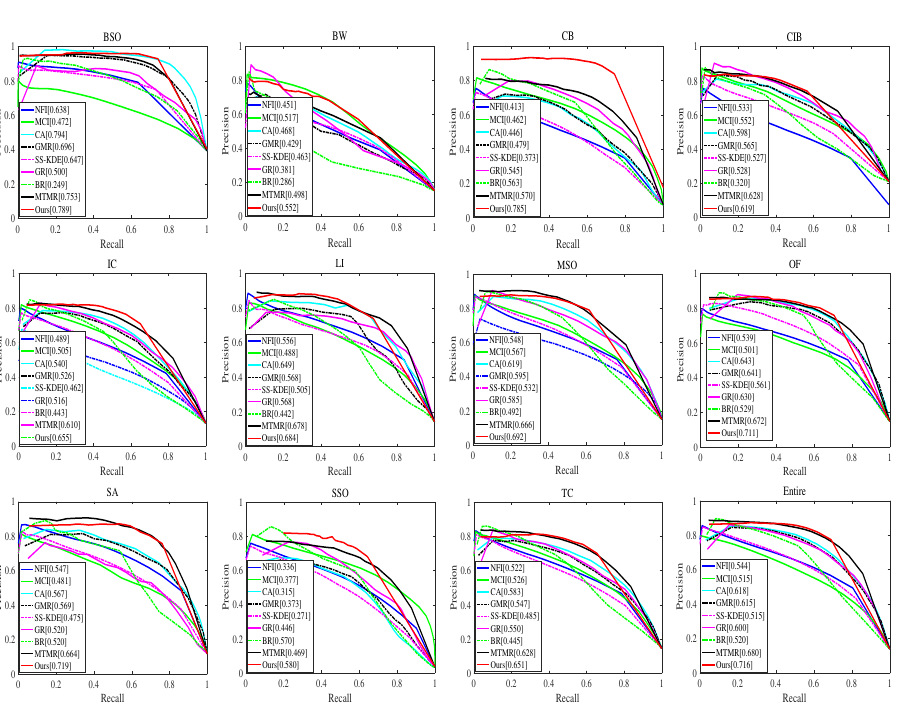
Figure 3. PR curves of the proposed approach with other baseline methods with RGB-T input on eleven subsets and the entire dataset. The F 0.3 values are shown in the